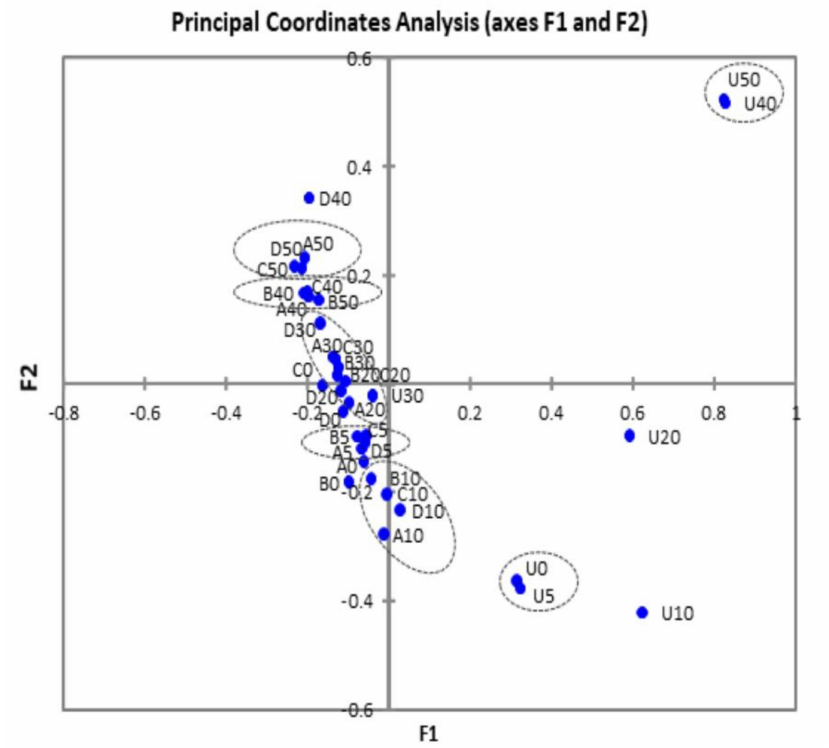
Figure 2. Principal coordinates analysis of guacamole samples treated or not by HP. U, untreated controls. HP treatments: A, 450 MPa at 22 ◦ C; B, 450 MPa at 50 ◦ C; C, 600 MPa at 22 ◦ C; and D, 600 MPa at 50 ◦